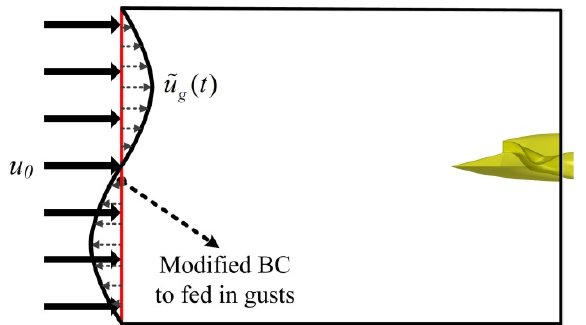
Figure 3. Illustration of the implementation of the current FVM gust modeling method.